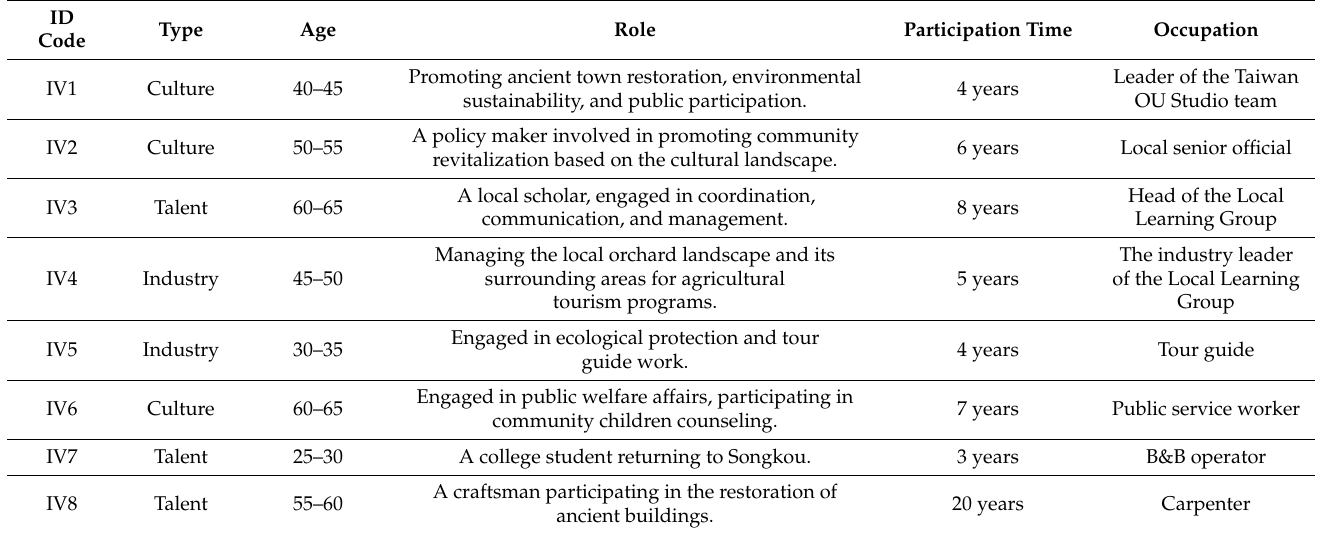
Table 1. List of